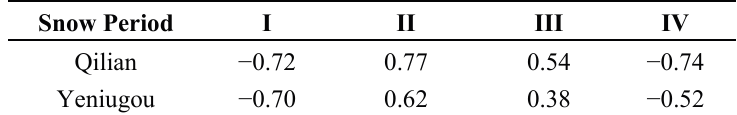
Figure 7. SCA (red) at elevation zones ( a ) 1708–3000 m and ( b ) 3000–3500 m and corresponding mean air temperature (blue) (T air ) at Qilian station (a) and Yeniugou (b) from HY2003 to HY2013. A year is divided into four periods I, II, III, and IV (purple dashed lines). Table 2. Pearson correlation coefficients ( p < 0.001) between average snow cover area and mean air temperature during the four different snow cover periods (indicated in Figure 7) at Qilian and Yeniugou stations from HY2003 to